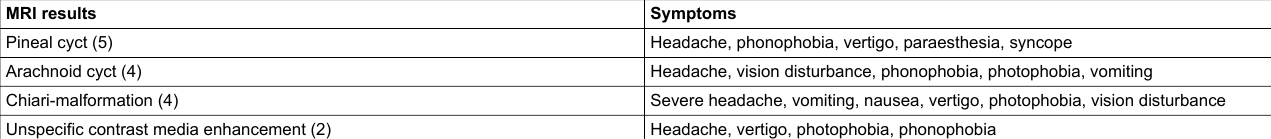
Table 1: Cranial MRI results and most common symptoms in five most common conditions on imaging studies. MRI